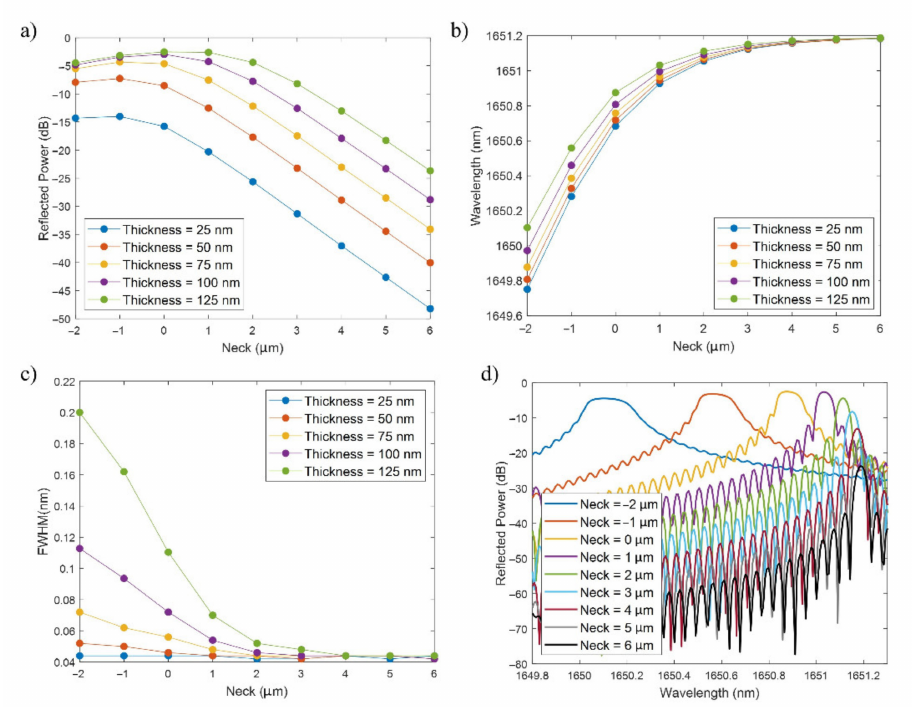
Figure 5. ( a ) FBG band reflected peak power (dB) versus neck ( µ m), ( b ) FBG band wavelength (nm) versus neck ( µ m), and ( c ) FBG band FWHM (nm) versus neck ( µ m), for different values of the thin film thickness. ( d ) FBG band for different necks and a thin-film thickness of 125